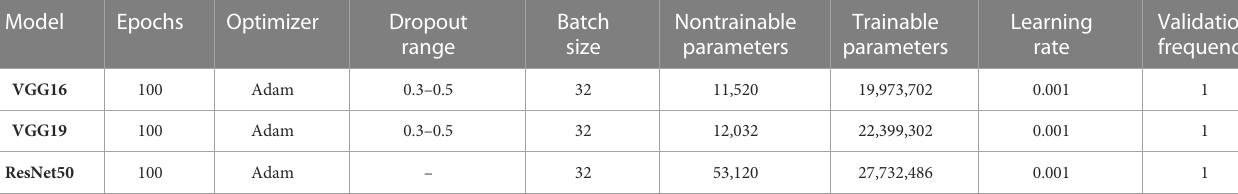
TABLE 2 Model setup and list of hyperparameters used for training.